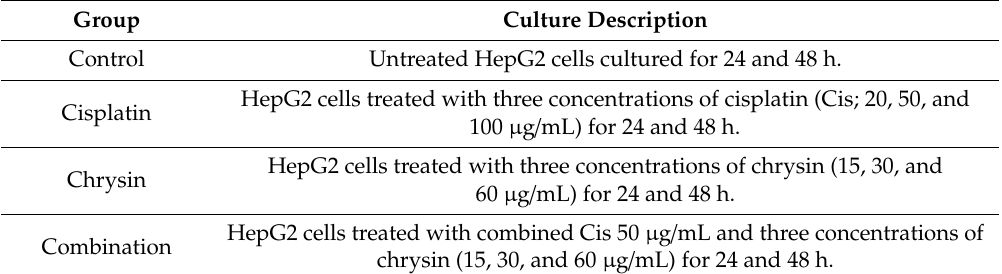
Table 1. Treatment protocol of HepG2 cells with di ff erent concentrations of cisplatin and chrysin at di ff erent time